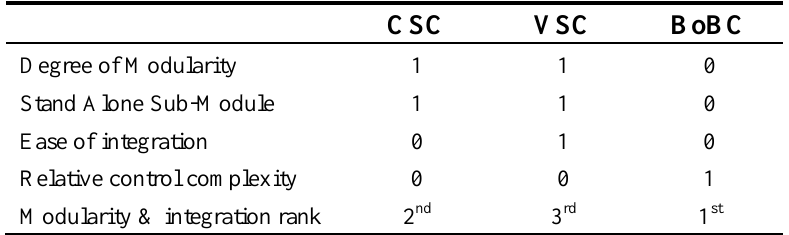
Table 10. Converter modularity and integration penalty